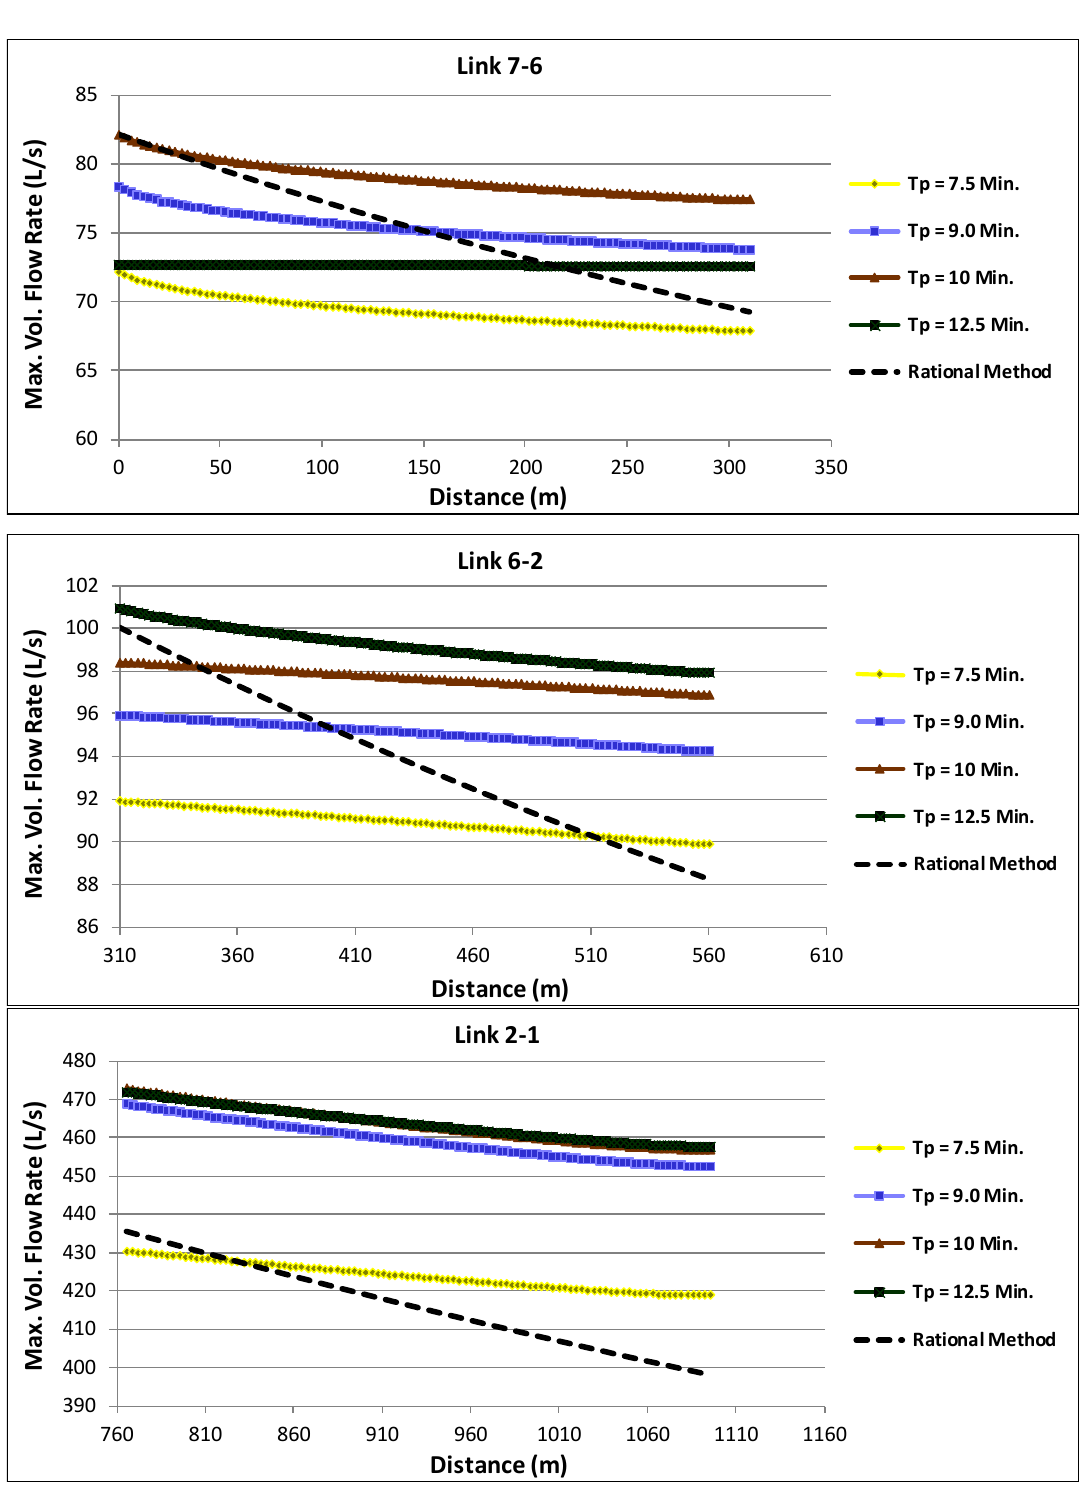
Figure 5. Comparison of simulation in open channel gradually varied unsteady flow for several times of precipitation with the rational method along a dendritic network.